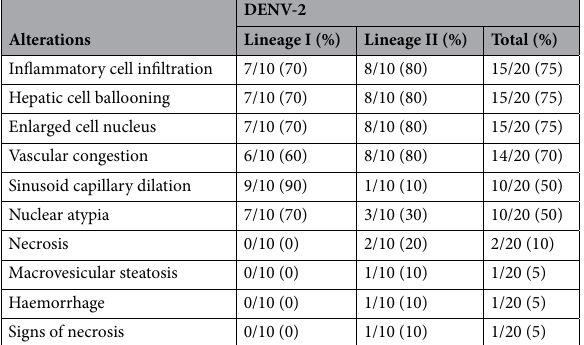
Table 1. Histopathological alterations observed in liver samples of BALB/c infected with DENV-2 Lineages I or II. Number of mice whose livers presented the alteration/total number infected